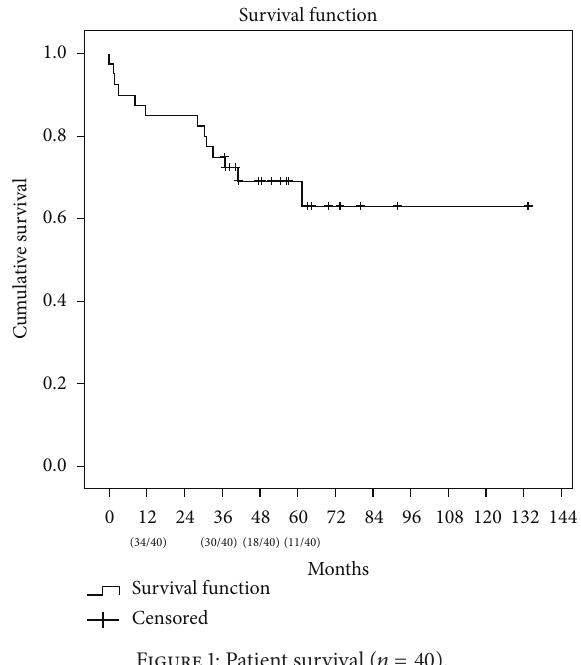
Figure 1: Patient survival ( 𝑛 = 40